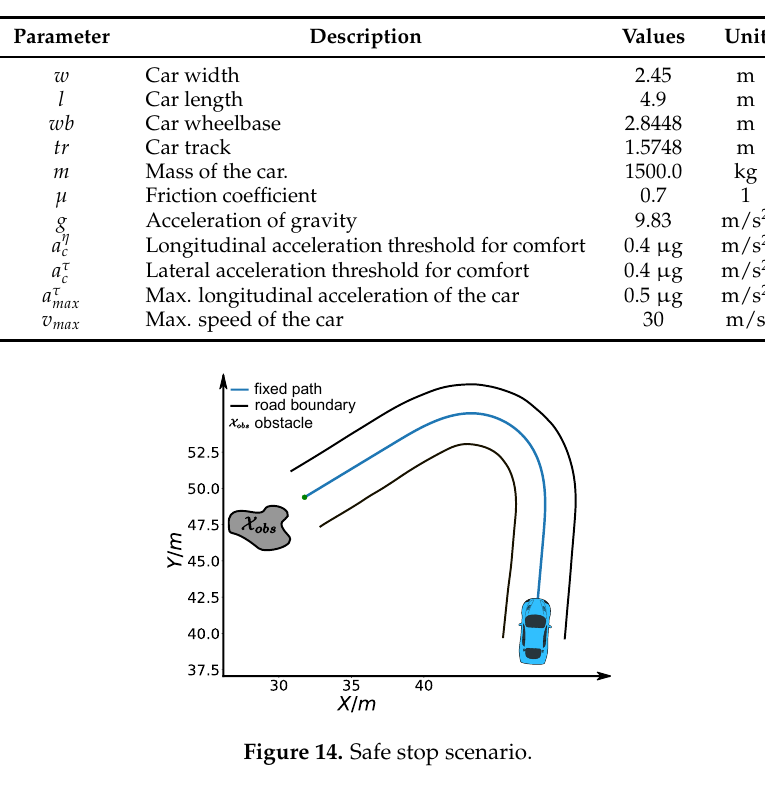
Table 5. Parameter Values.